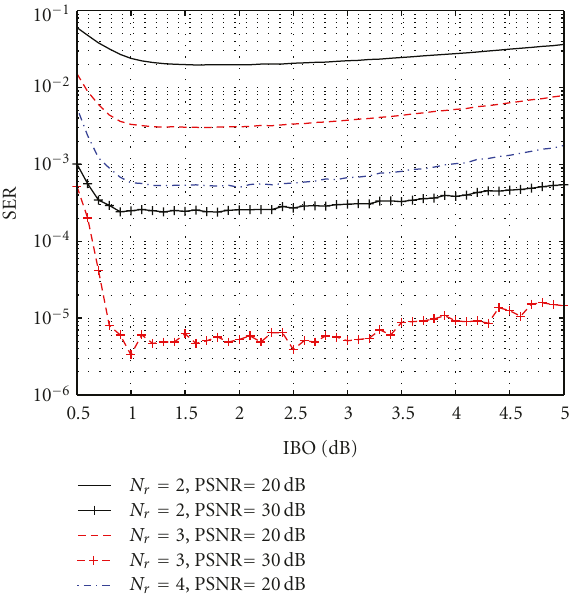
Figure 6: For PSNR = 20dB or 30 dB, the SER versus IBO curves for the joint MRC and clipping mitigation method with N r = 2, 3, or 4 receiving antennas and 5